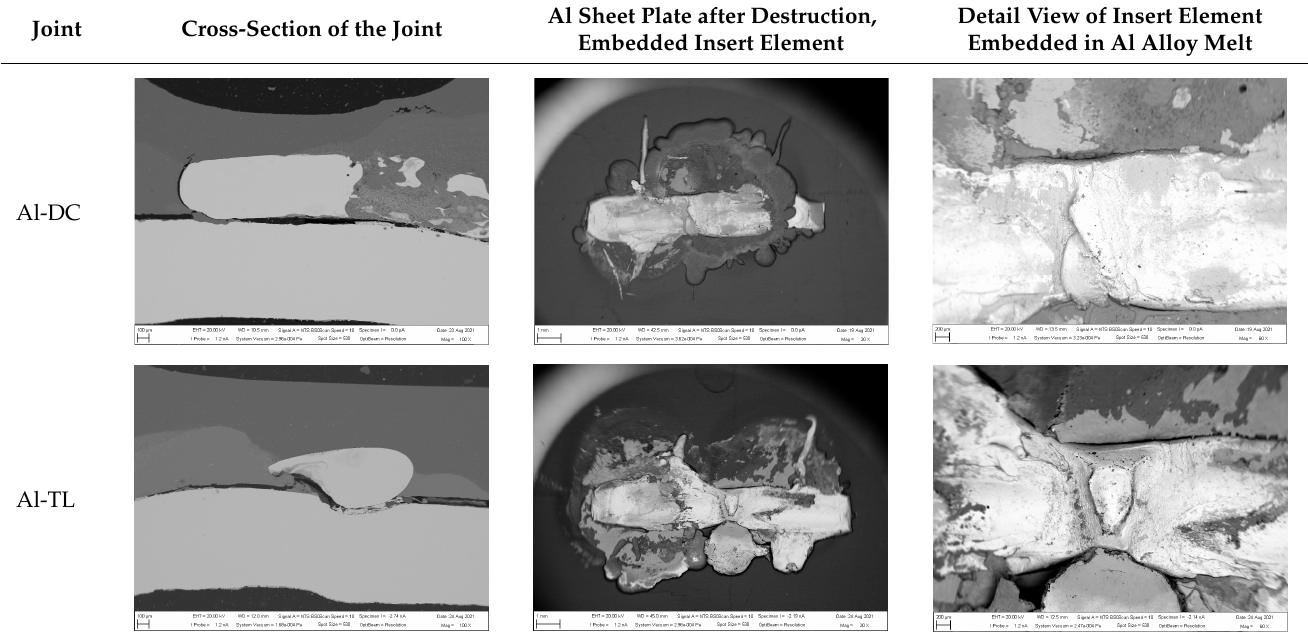
Table 11. SEM analysis of cross-sections and fracture surfaces of welded joints.